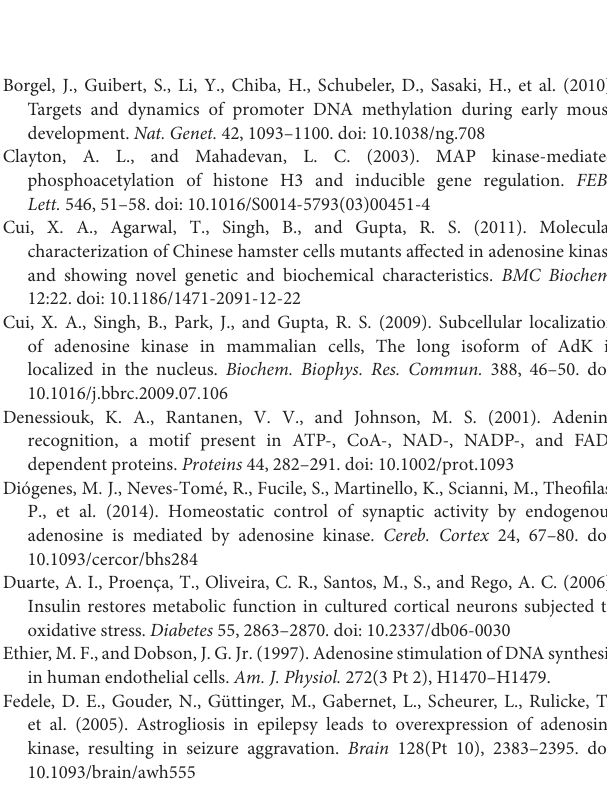
Supplement Figure 1 | Brains of P4 and P14 rat pups were removed, hippocampi resected and then enzymatically and mechanically dissociated. Cell suspension was pre-plated for 1 h, to separate glial (yellow) and neuronal cell populations (gray) by sedimentation. Afterwards, cells were immediately fixed with formalin or lysed for downstream